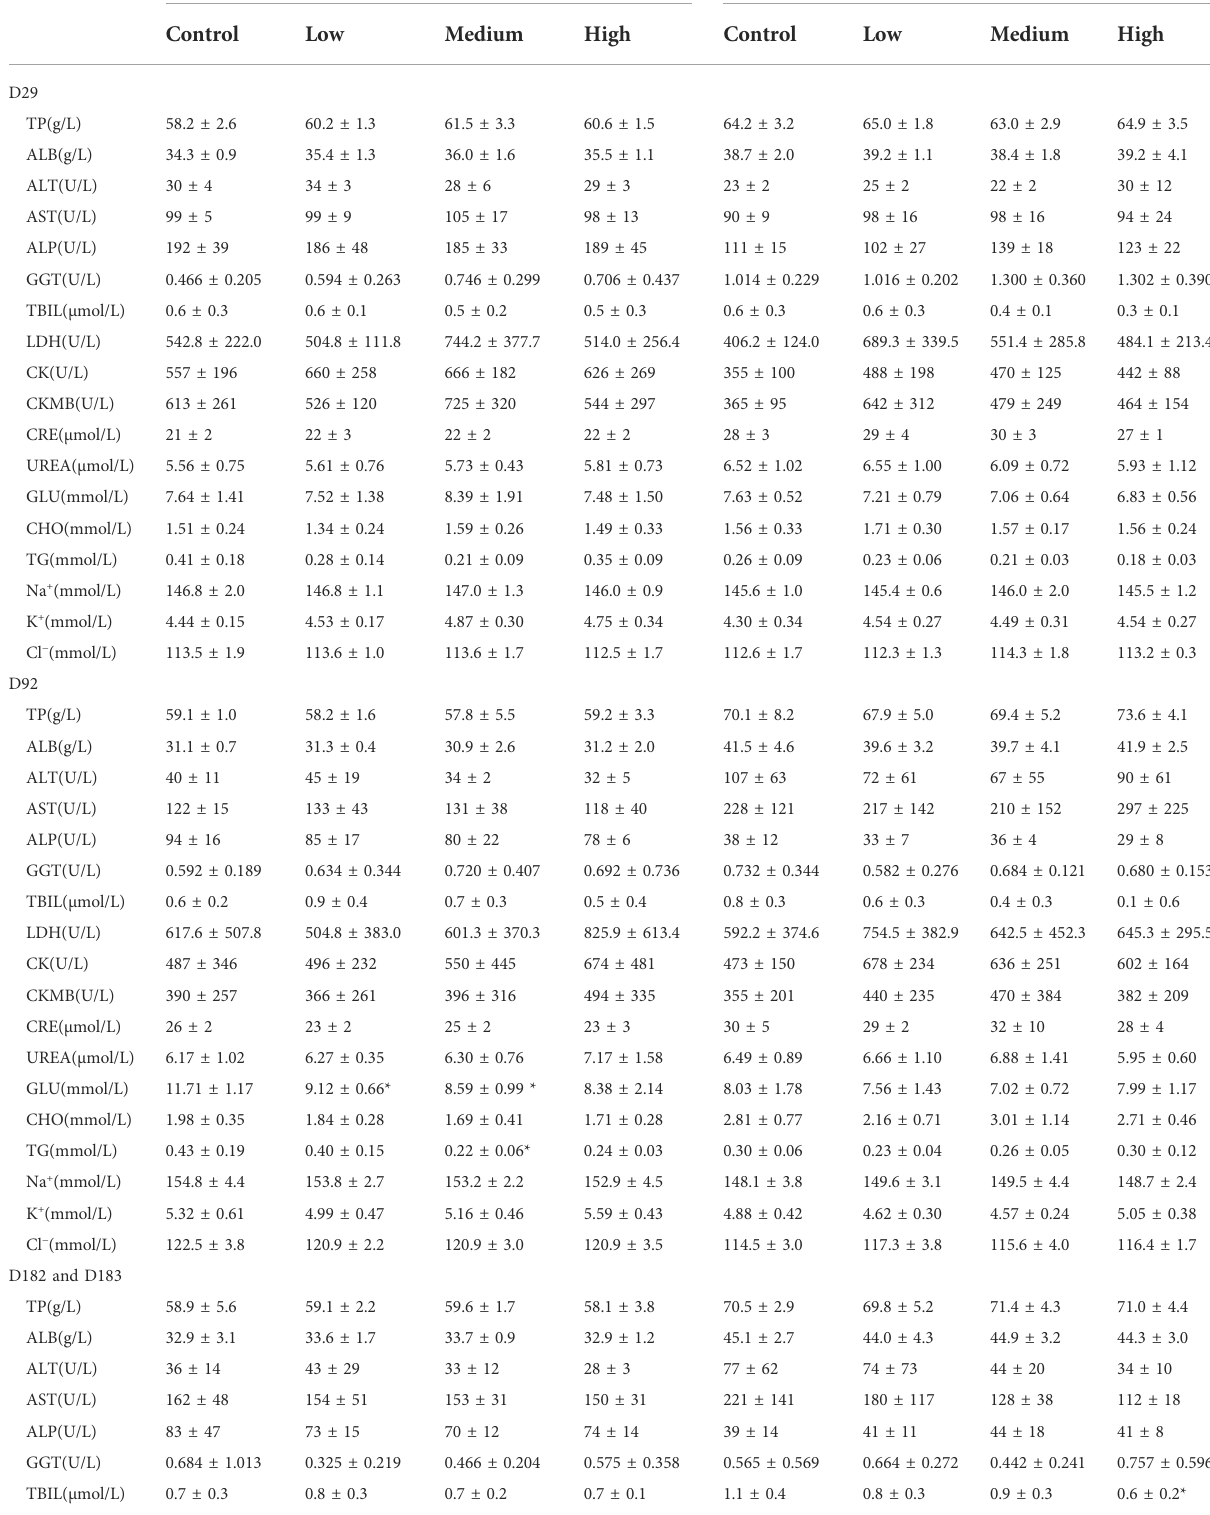
TABLE 3 Blood biochemistry parameters in rats treated with DLTD. Parameter Male